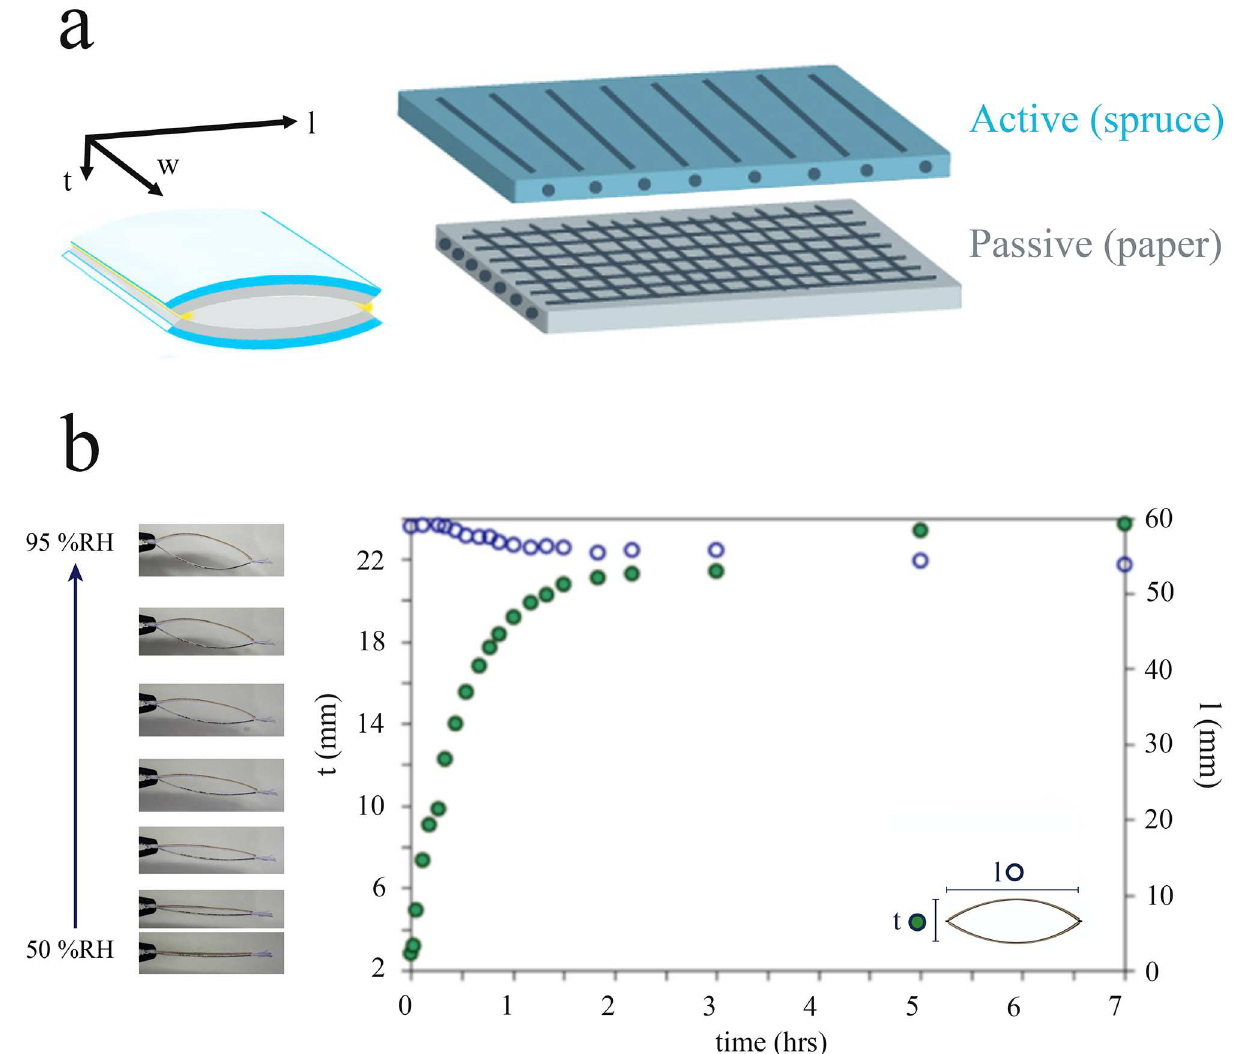
Fig 6. Structure and deformation of the bilayer-cell upon actuation. (a) Spatial arrangement of spruce (active) and paper (passive) layers in the bilayer-cell,with the corresponding fibers’ orientationwithin each layer. (b) Dimensionalchanges of the bilayer-cells upon exposure from initial 50% RH to a 95% RH, with the corresponding sequentialimages of the hydro-actuated movement (t = cell width, l = cell